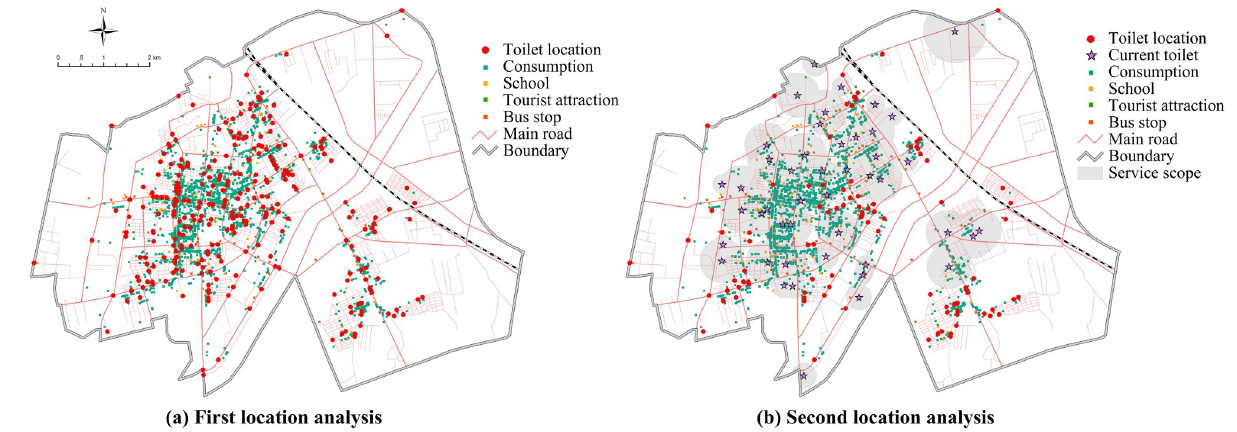
Fig 8. The first and second location analysis process (copyright hold by the